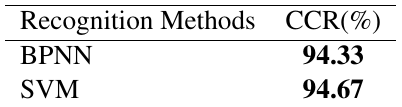
Table 3. CCRs of the three recognition